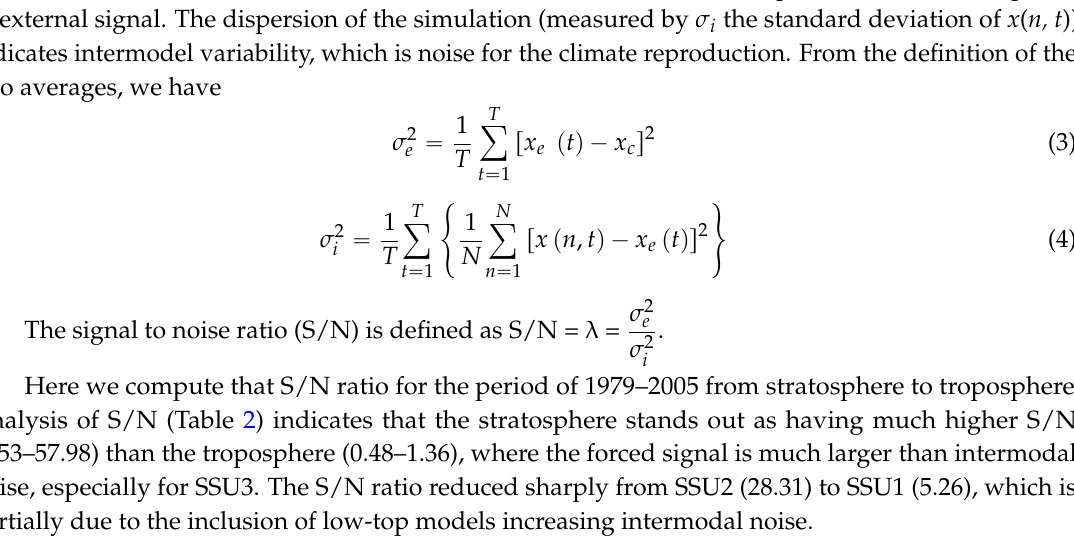
Table 2. Signal-to-noise ratio (S/N) for stratospheric and tropospheric air